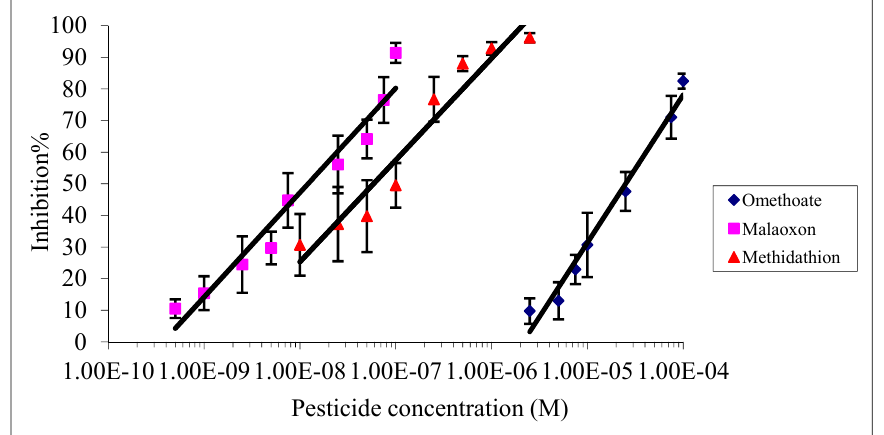
Figure 2. Inhibition effect of omethoate, methidathion and malaoxon on electric eel AChE immobilized on magnetic beads, measurement by colorimetric